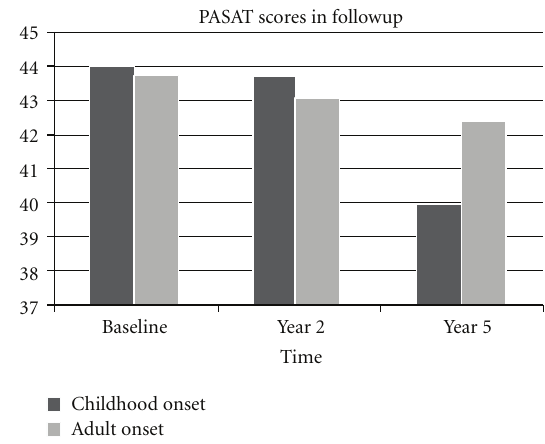
Figure 2: PASAT in the follow-up period (PASAT at baseline versus the 5th year, P = 0 . 008).